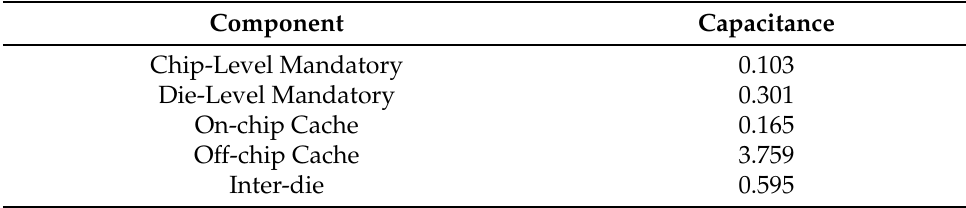
Table 4. Capacitance of different components of the